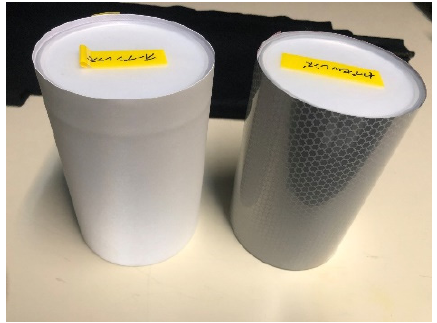
Figure 5. Cylinder with curved surface covered with retroreflective material (left: open lens type, right: encapsulated lens type).